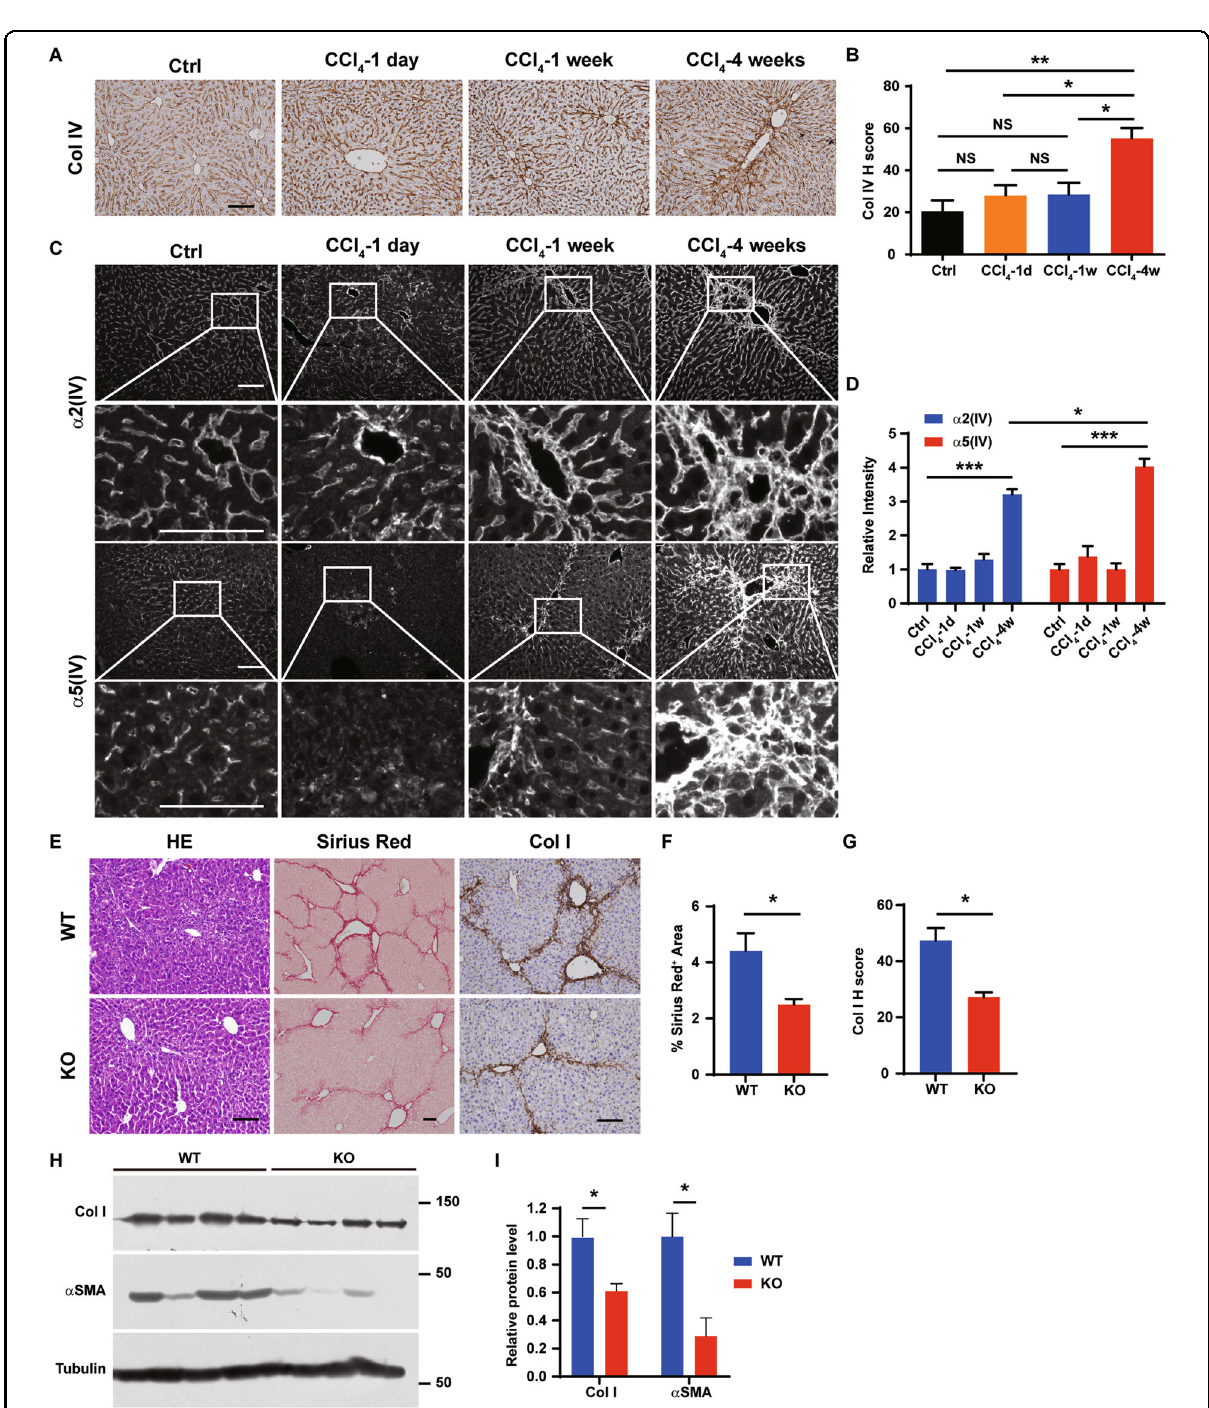
Fig. 4 Minor type IV collagen is essential for CCl 4 -induced liver fi brosis. A , B Immunostaining of type IV collagen on liver sections. Quanti fi cation of Col IV is shown in B . N = 3. Scale bars: 100 μ m. C , D Immunostaining of major type IV collagen α 2 chain and minor type IV collagen α 5 chain on liver sections. Quanti fi cation of α 2 chain and α 5 chain is shown in D . N = 3 (1-day and 1-week) or 4 (Control and 4-week). Scale bars: 100 μ m. E – H Wild-type (WT) and Col4a5 knockout (KO) mice were intraperitoneally injected with CCl 4 for 4 weeks. E – G Liver sections are stained with hematoxylin-eosin (HE), Picrosirius Red or immunostained for type I collagen (Col I). Quanti fi cation of percentage of Picrosirius Red-positive area and Col I are shown in F , G . N = 3. Scale bars: 100 μ m. H , I Western blot analyses of Col I and α SMA in the livers of WT and KO mice intraperitoneally injected with CCl 4 for 4 weeks. Quanti fi cation is shown in I . N = 4. Data are presented as mean±SEM. Statistical analyses were performed with one-way Anova followed by Tukey ’ s post-hoc analysis or two-tailed unpaired student ’ s t test. * P